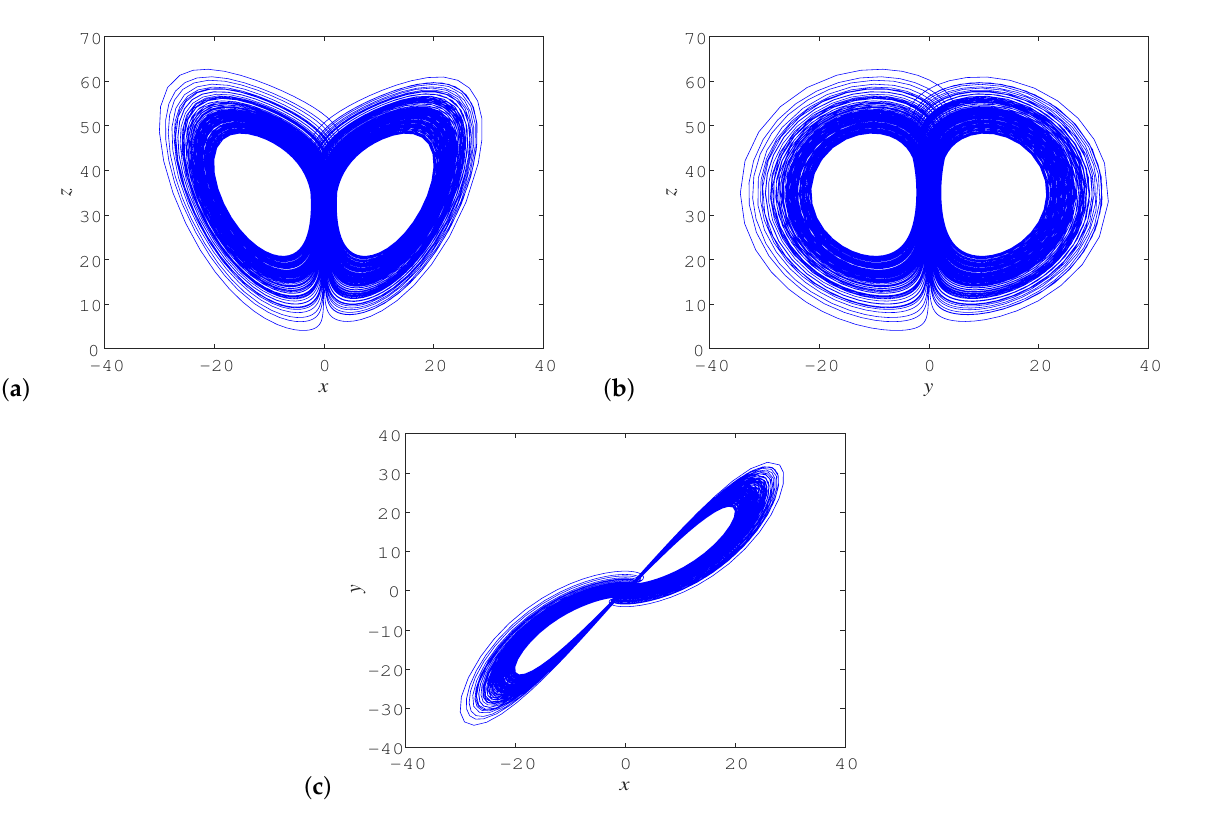
Figure 1. Two-dimensional projections of chaotic attractor onto various planes at time t = 150: ( a ) x − z , ( b ) y − z , and ( c ) x − y